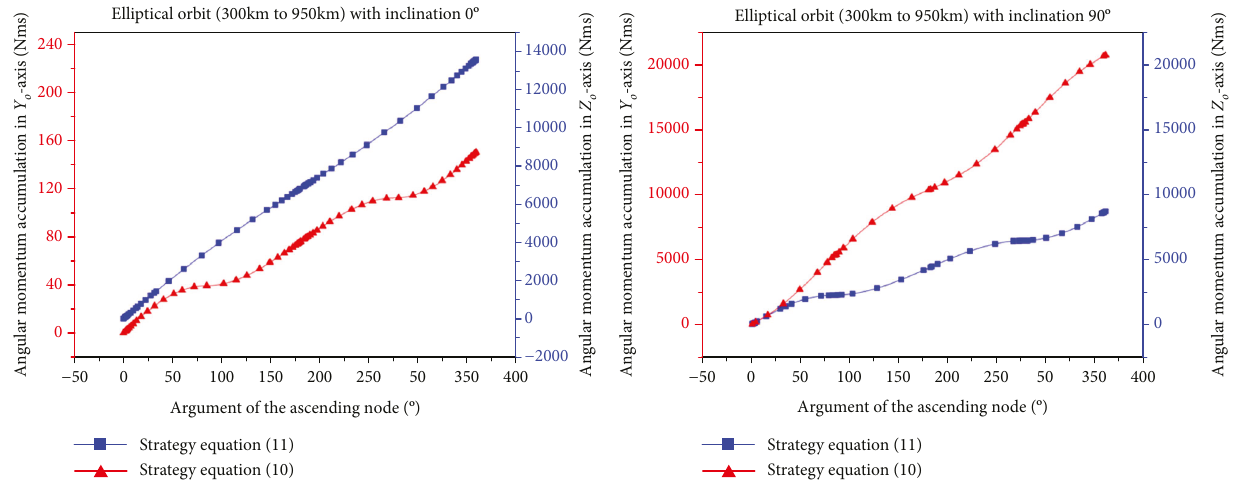
Figure 8: Main angular momentum accumulation (orbital coordinates) in the elliptical orbit with an inclination of 0 ° /90 ° (300km to 950km) under equations (11) and (10) (example